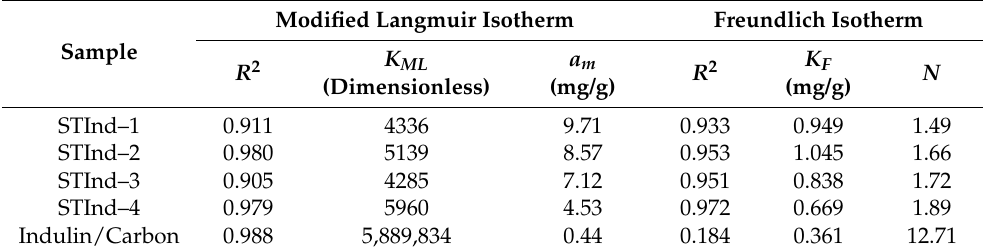
Table 5. Parameters of modified Langmuir and Freundlich isotherms for methylene blue adsorp- tion on biochars.